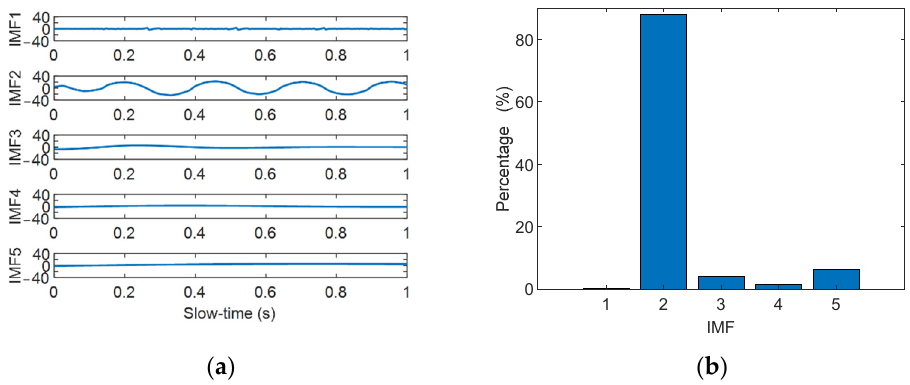
Figure 10. Estimation results of the coning frequency by using the EMD method. ( a ) Decomposition results of micro-Doppler frequency shift. ( b ) The energy ratio of each decomposition signal.